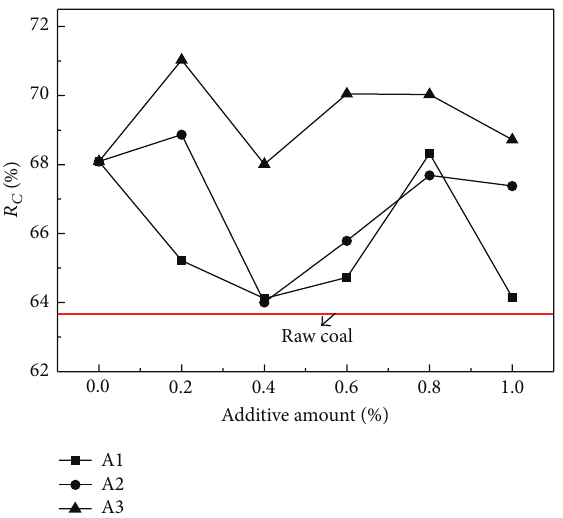
Figure 3: The effect of additive on 𝑅 𝐶 of